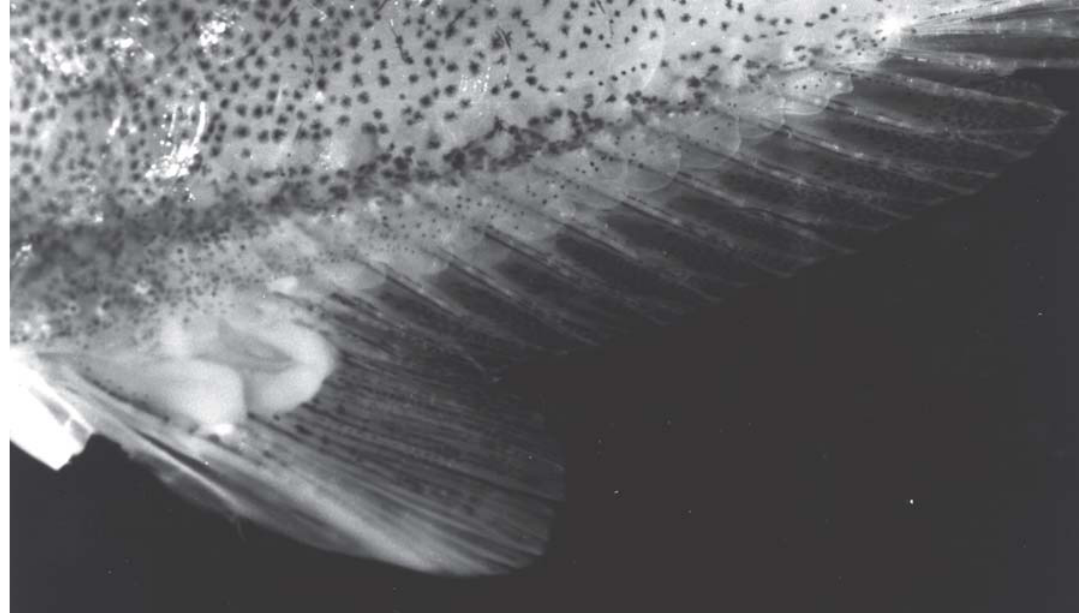
Fig. 7. Bryconadenos tanaothoros , new species, USNM 352061, paratype, SL 36.6 mm, adult male. Lateral view of left side of anterior region of anal fin illustrating glandular organ. Brazil: Mato Grosso: tributary to rio Suiazinho, near Ribeirão